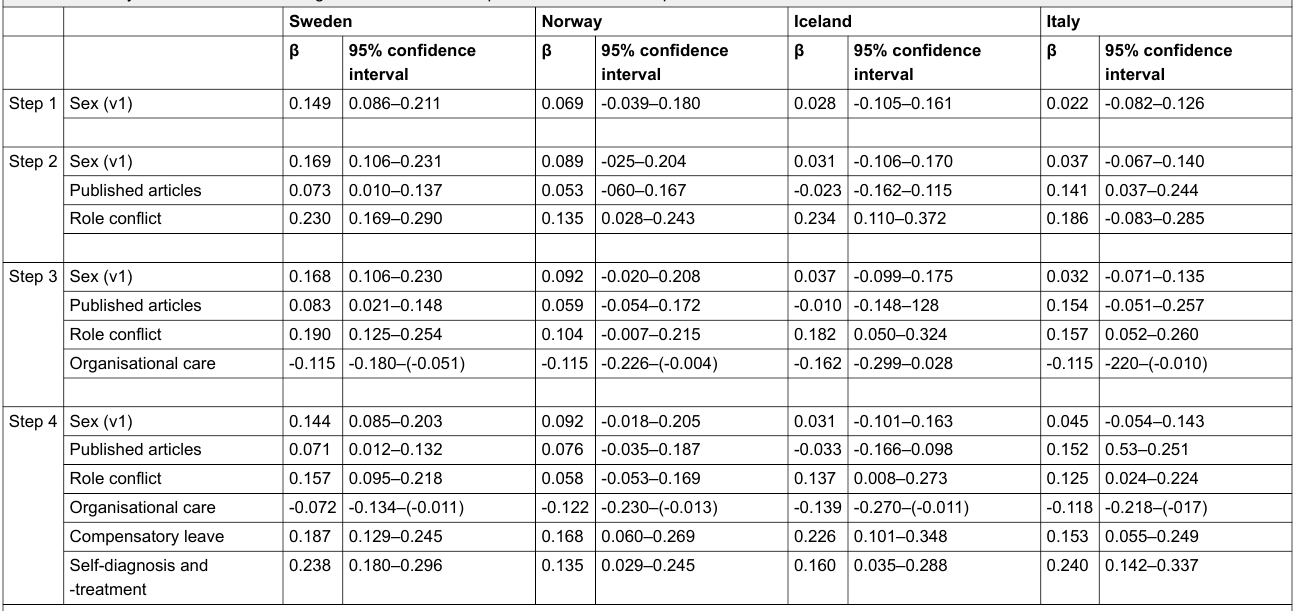
Table 3: Country-stratified hierarchical regression with sickness presenteeism as the dependent